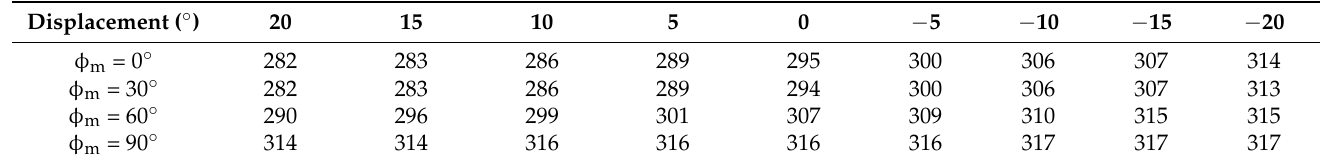
Table 2. The wavelengths corresponding to the maximum reflectance for viewing angles ± 20 ◦ displaced from the specular direction of θ m = 30 ◦ for a number of azimuthal viewing planes, for a 40 BIOS pass opal. Error in wavelengths of ± 0.5